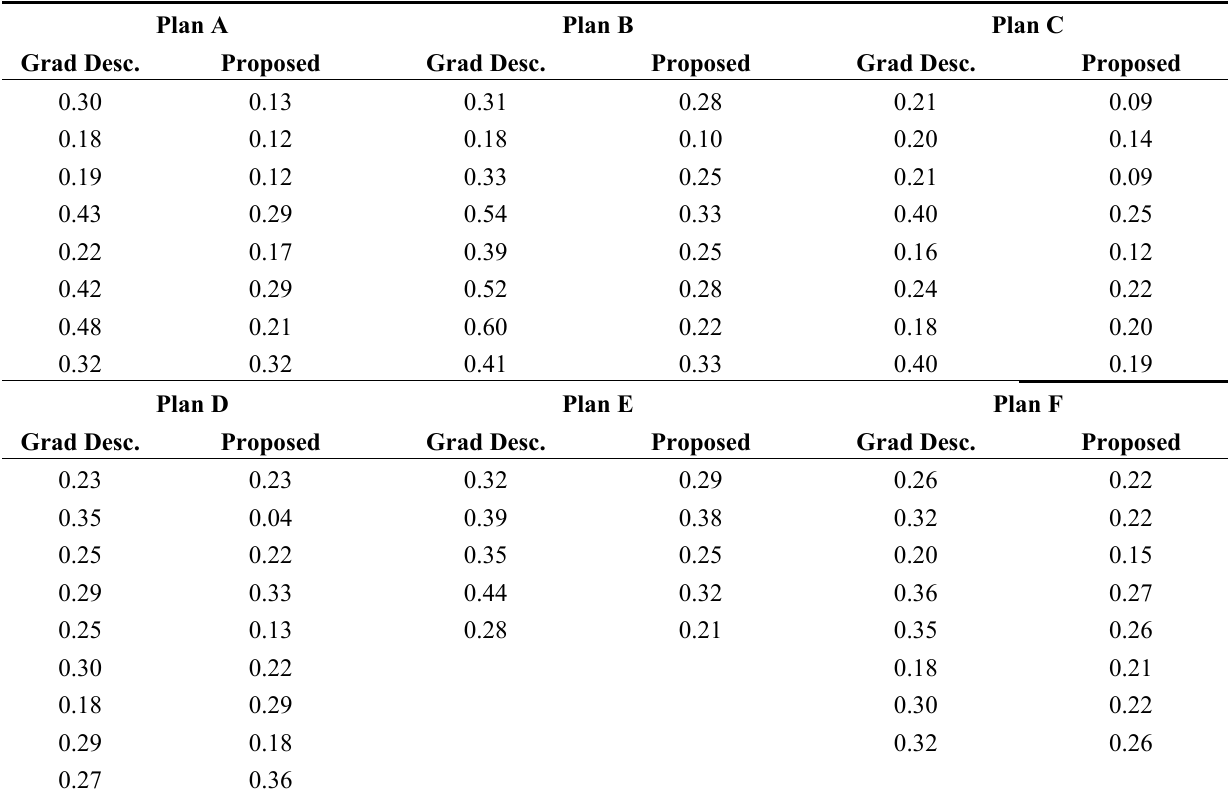
Table B1. RMSE (m) for each room in plan using gradient-descent and proposed